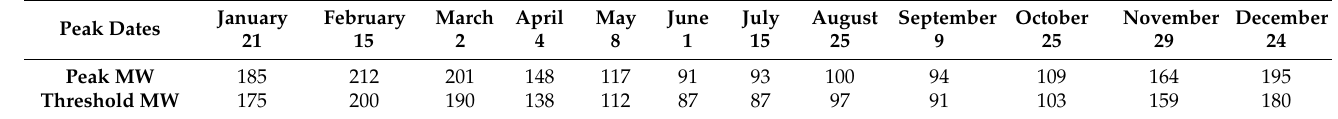
Table 5. Maximum peaks and for each billing cycle of peak load